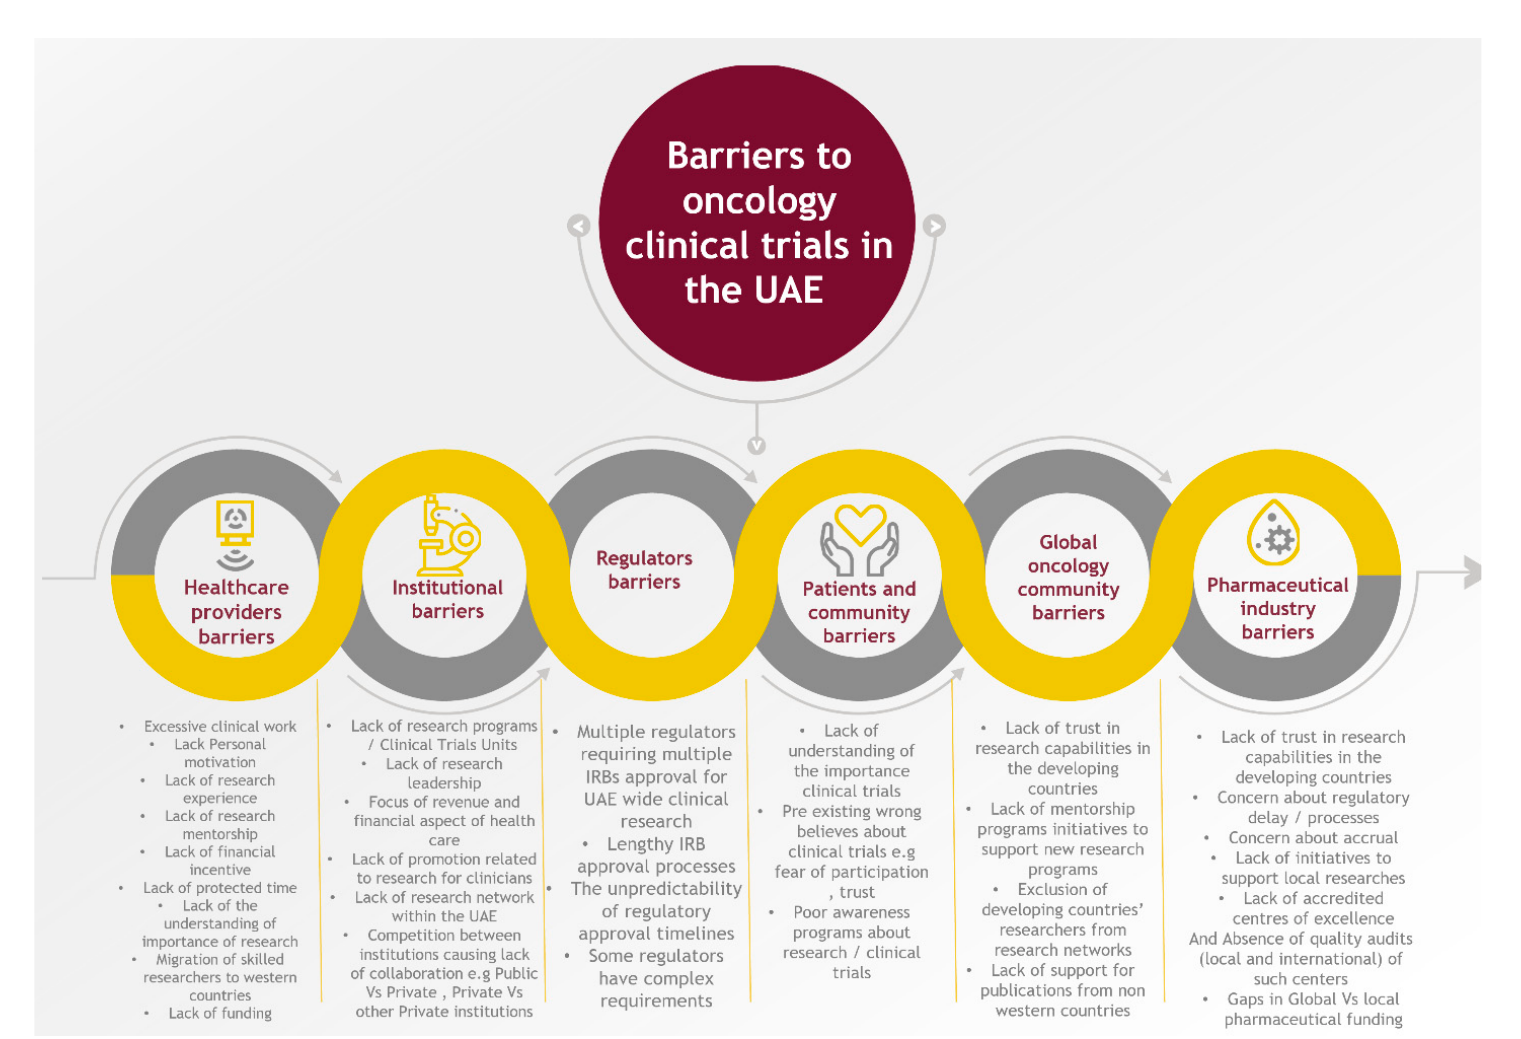
Figure 2. Barriers to oncology clinical trials in the UAE.